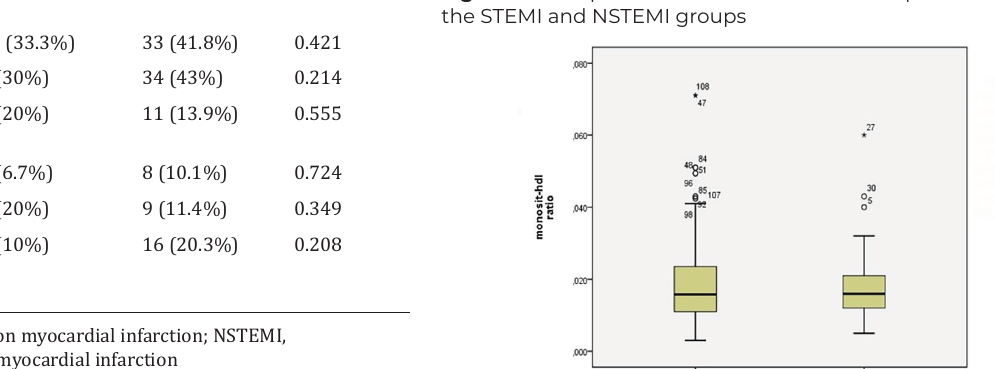
Comparison of the characteristics between the and MHR were 2.22 (1.47-4.14), 0.035 (0.029-0.042), and 0.016 STEMI and NSTEMI groups. (0.011-0.022), respectively. The comparisons of the laboratory parameters between the STEMI and NSTEMI groups are shown in Table 2, and the comparison of the MHR between the two groups is presented in Figure 2. Significant differences were detected between the STEMI and NSTEMI groups in relation to the neutrophil count [7.27 (6.05-9.05) versus 5.41 (4.26-7.21), p < 0.001] and mean platelet volume [9.4 (8.8-10) versus 8.6 (7.3- 9.5), p = 0.002]. However, there was no statistically significant difference between the two groups in the term of MHR [0.016